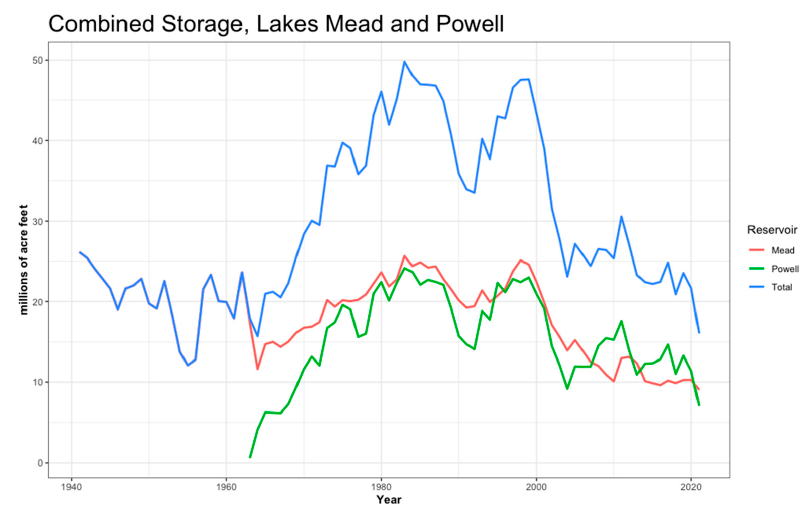
Figure 2. Total Storage in Lakes Mead and Powell. Data: U.S. Bureau of Reclamation.